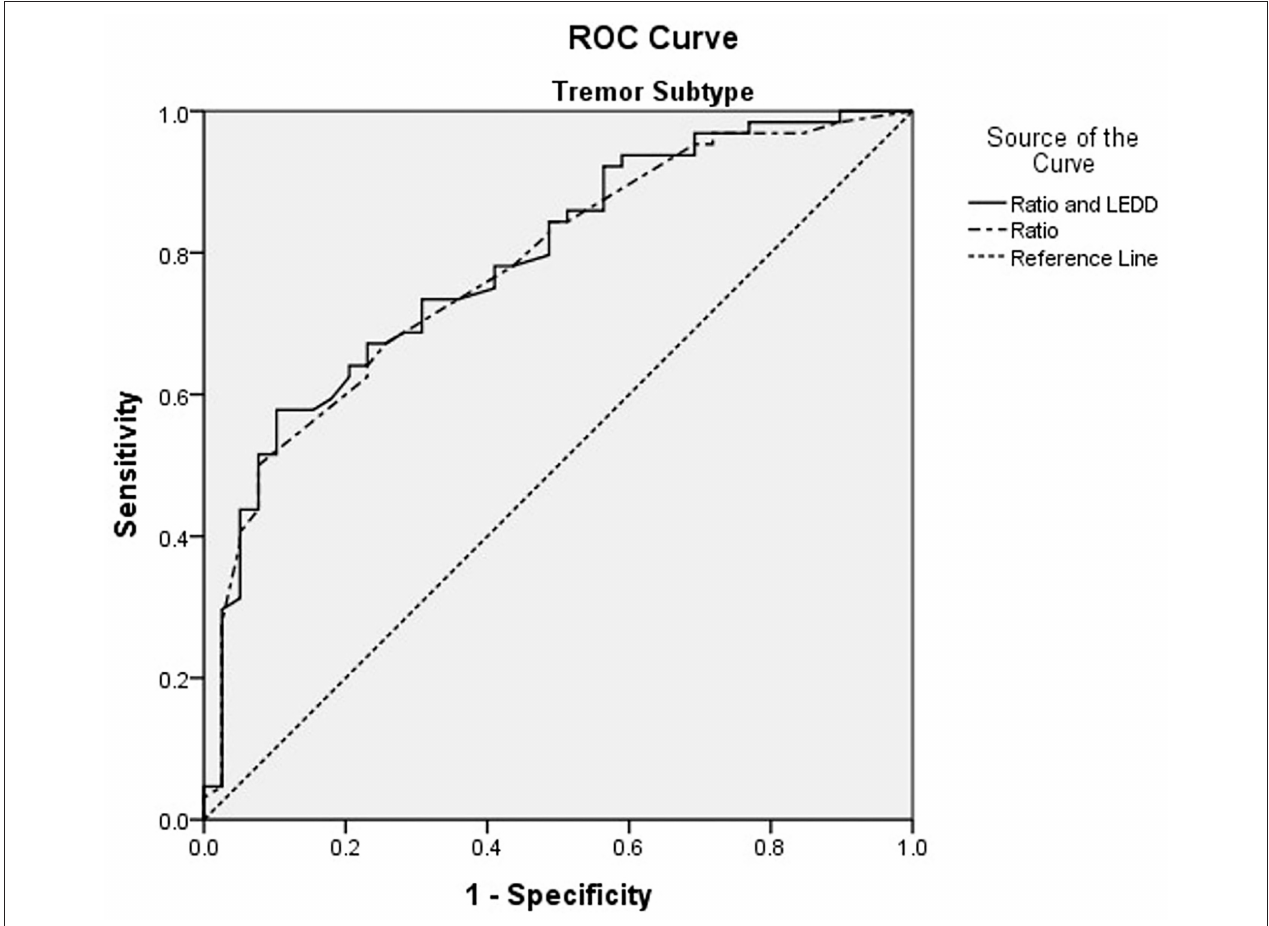
FIGURE 2 | ROC curve of levodopa equivalent daily dose (LEDD) and tremor dominant (TD)/ postural instability and gait difficulty (PIGD) ratio for TD subtype